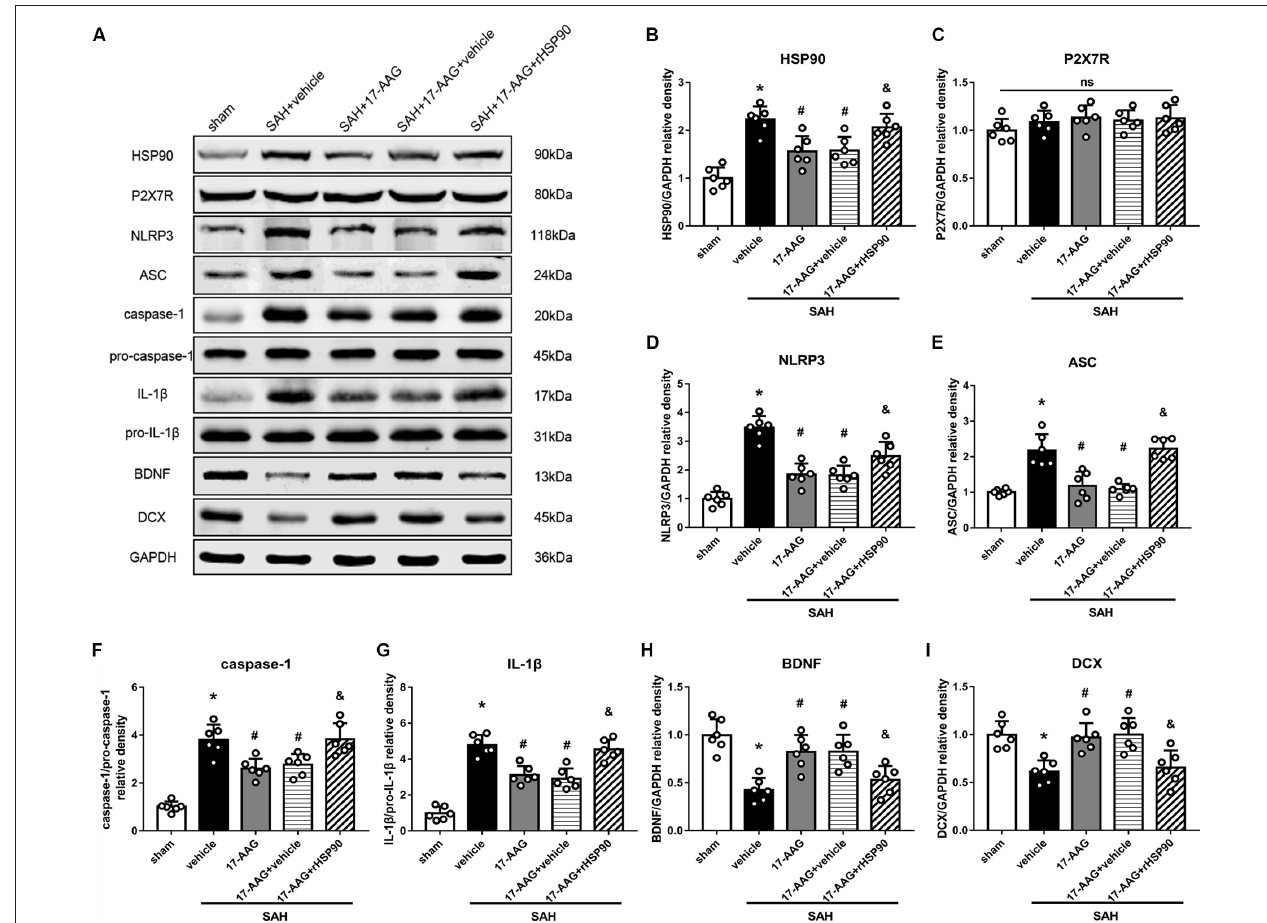
FIGURE 5 | Effects of 17-AAG and recombinant HSP90 (rHSP90) on the expression of HSP90 and its downstream signaling proteins 48 h after SAH. (A) Representative western blots. (B–I) Quantitative analyses of HSP90, P2X7 receptor (P2X7R), NLRP3, ASC, caspase-1, interleukin-1 β (IL-1 β ), brain-derived neurotropic factor (BDNF) and DCX in the left hemisphere; n = 6 per group. ns, no significant. ∗ P < 0.05 vs. sham group; # P < 0.05 vs. SAH + vehicle group; & P < 0.05 vs. SAH + 17-AAG + vehicle. The error bars represent